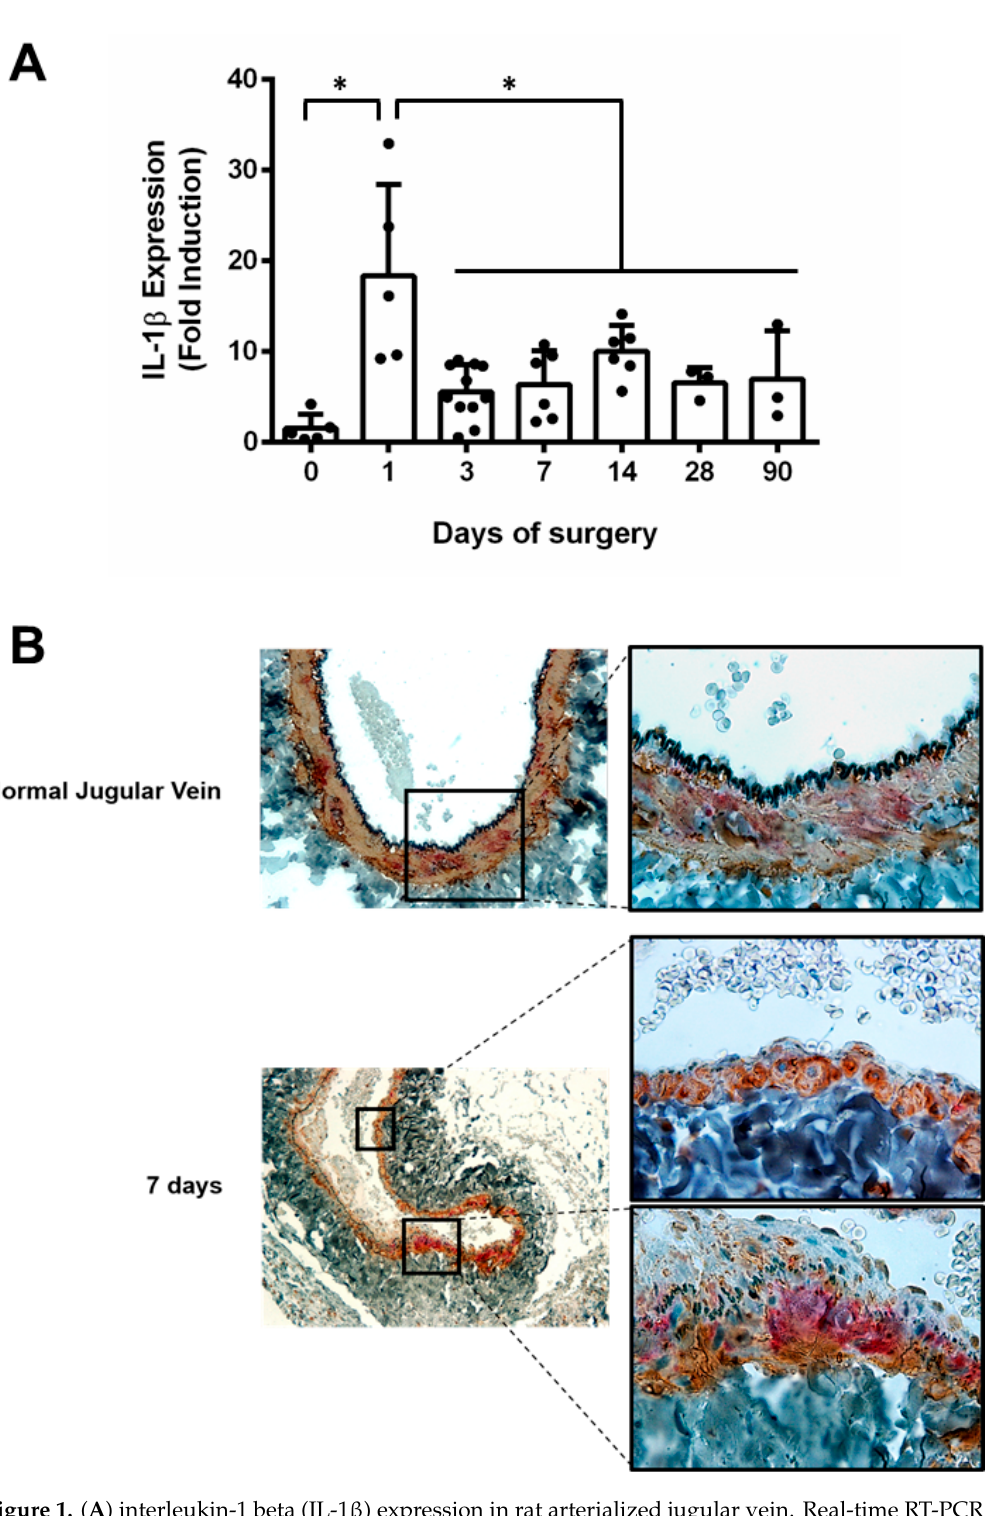
Figure 1. ( A ) interleukin-1 beta (IL-1 β ) expression in rat arterialized jugular vein. Real-time RT-PCR in arterialized jugular vein up to 90 days. The experiment was normalized by 28S rRNA, and each bar represents mean ± SD of 3 to 11 experiments. * indicates p < 0.05. ( B ) Immunohistochemistry for IL-1 β (red) and smooth muscle α -actin (brown) in arterialized jugular vein. Representative sections of normal jugular vein and arterialized jugular vein at 7